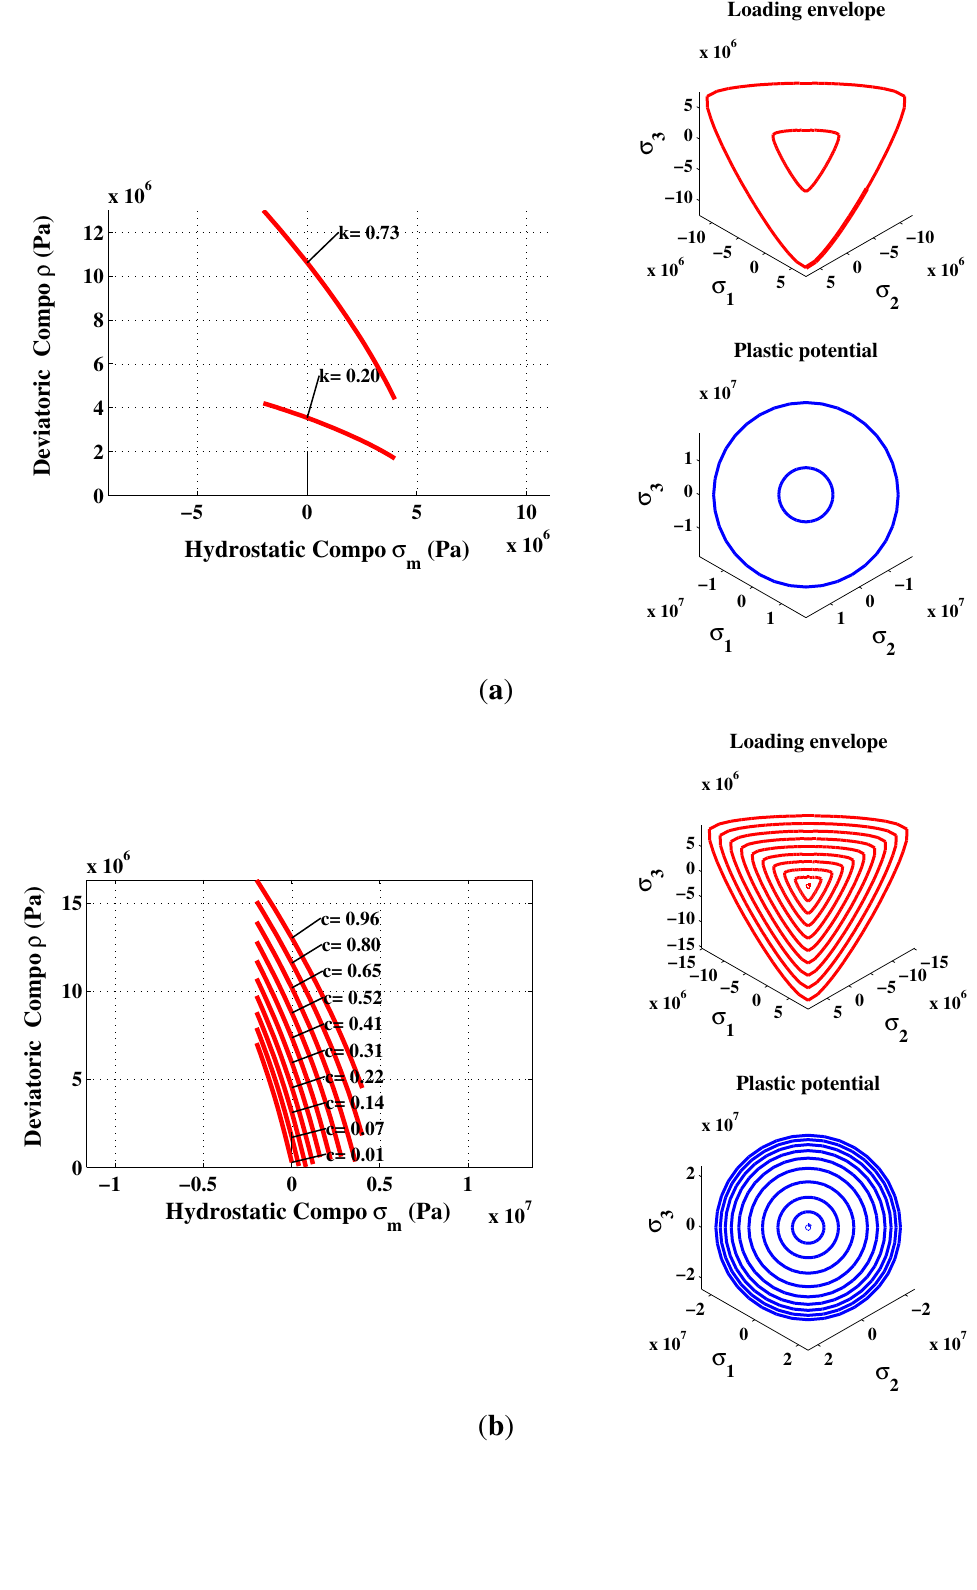
Figure 13. Hardening and softening stages in numerical pure shear test. ( a ) Hardening; ( b )